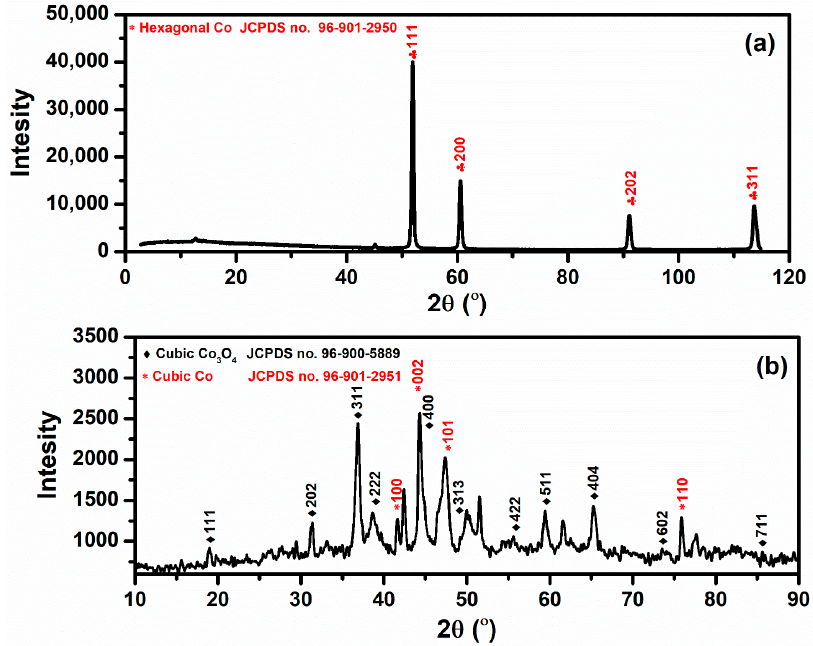
Figure 6. ( a ) XRD of HPC-Co (1) and ( b ) XRD of HPC-CoO (2). In the Raman spectra of HPC-Co, G band is characteristic of sp 2 hybridized carbon in ordered graphite and usually appears at 1576-1580 cm − 1 range [40]. HPC-Co shows G band at 1592 cm − 1 , Figure 7. The 12 cm − 1 upshift in G band is due to strain, doping and the num- ber of layers present in the HPC-Co nanocomposite [41]. The observed D band at 1339 cm − 1 is characteristic of sp 3 disordered or defected graphitic carbon, while the typical D band of defect graphite occurs at ~1350cm − 1 [42]. The shift in D band is due to oxygen functional groups in the HPC-Co (as XPS revealed) which caused variation in bond dis- tances of C-C and thus distortion of graphene [43]. The degree of graphitization is inferred